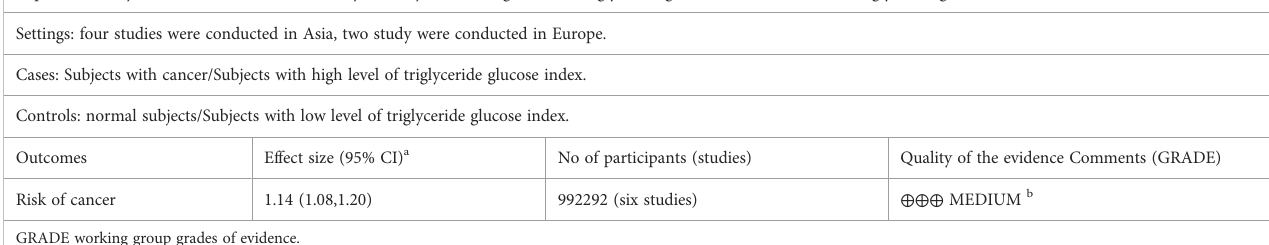
Settings: four studies were conducted in Asia, two study were conducted in Europe. Cases: Subjects with cancer/Subjects with high level of triglyceride glucose